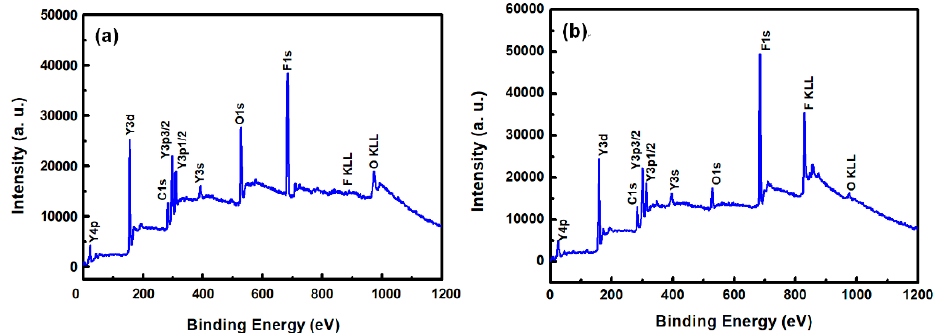
Figure 3. XPS survey spectra of the surfaces of the YF 3 thin films ( a ) before and ( b ) after exposure to CF 4 /O 2 plasma (under bombardment with argon ions for two minutes).